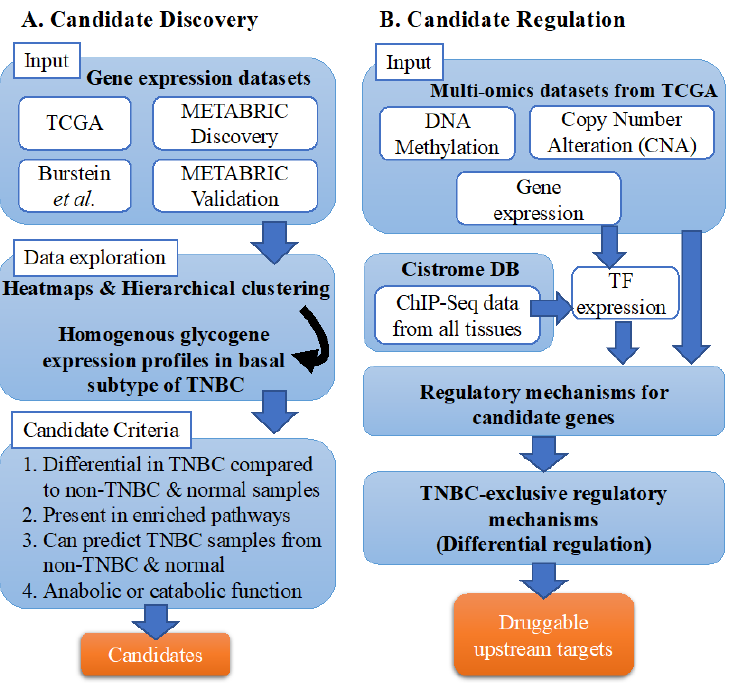
Figure 1. Study design and workflow. The study comprised two phases, discovery of candidate TNBC glycogenes ( A ), and identification of upstream regulatory mechanisms ( B ). TNBC, triple-negative breast cancer; TF, transcription factor.